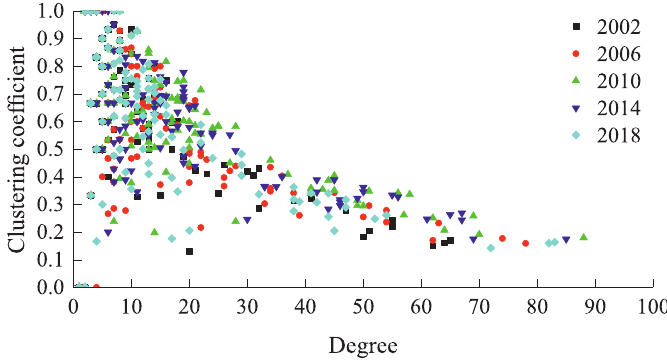
Figure 5. Cluster coefficient evolution in 2002, 2006, 2010, 2014 and